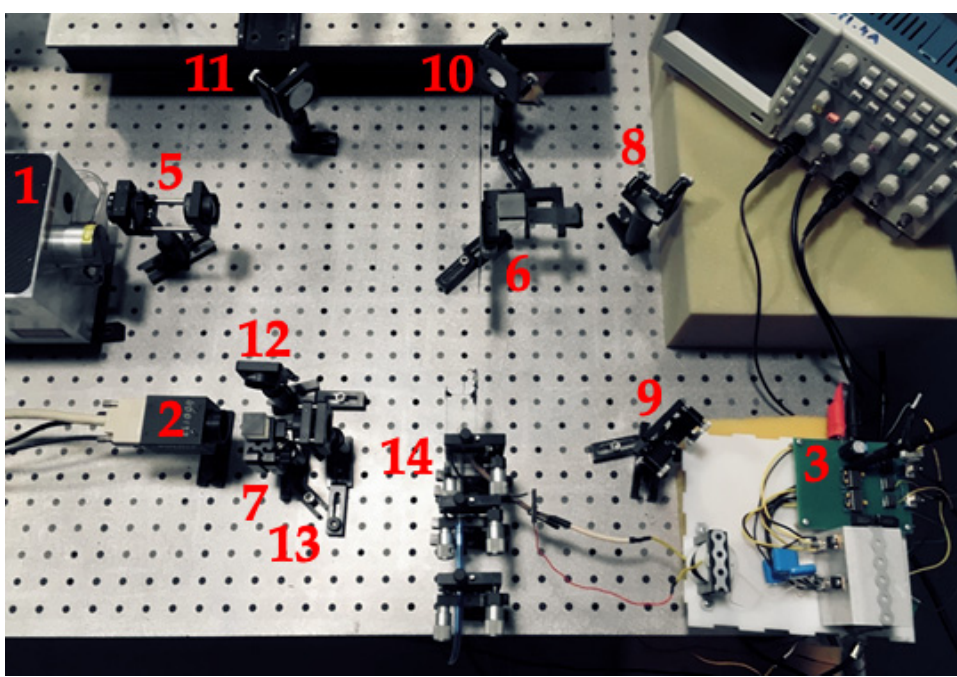
Figure 7. Configuration of the digital holographic interferometry setup for the study of plasma flow in the pulsed generation mode (photograph).